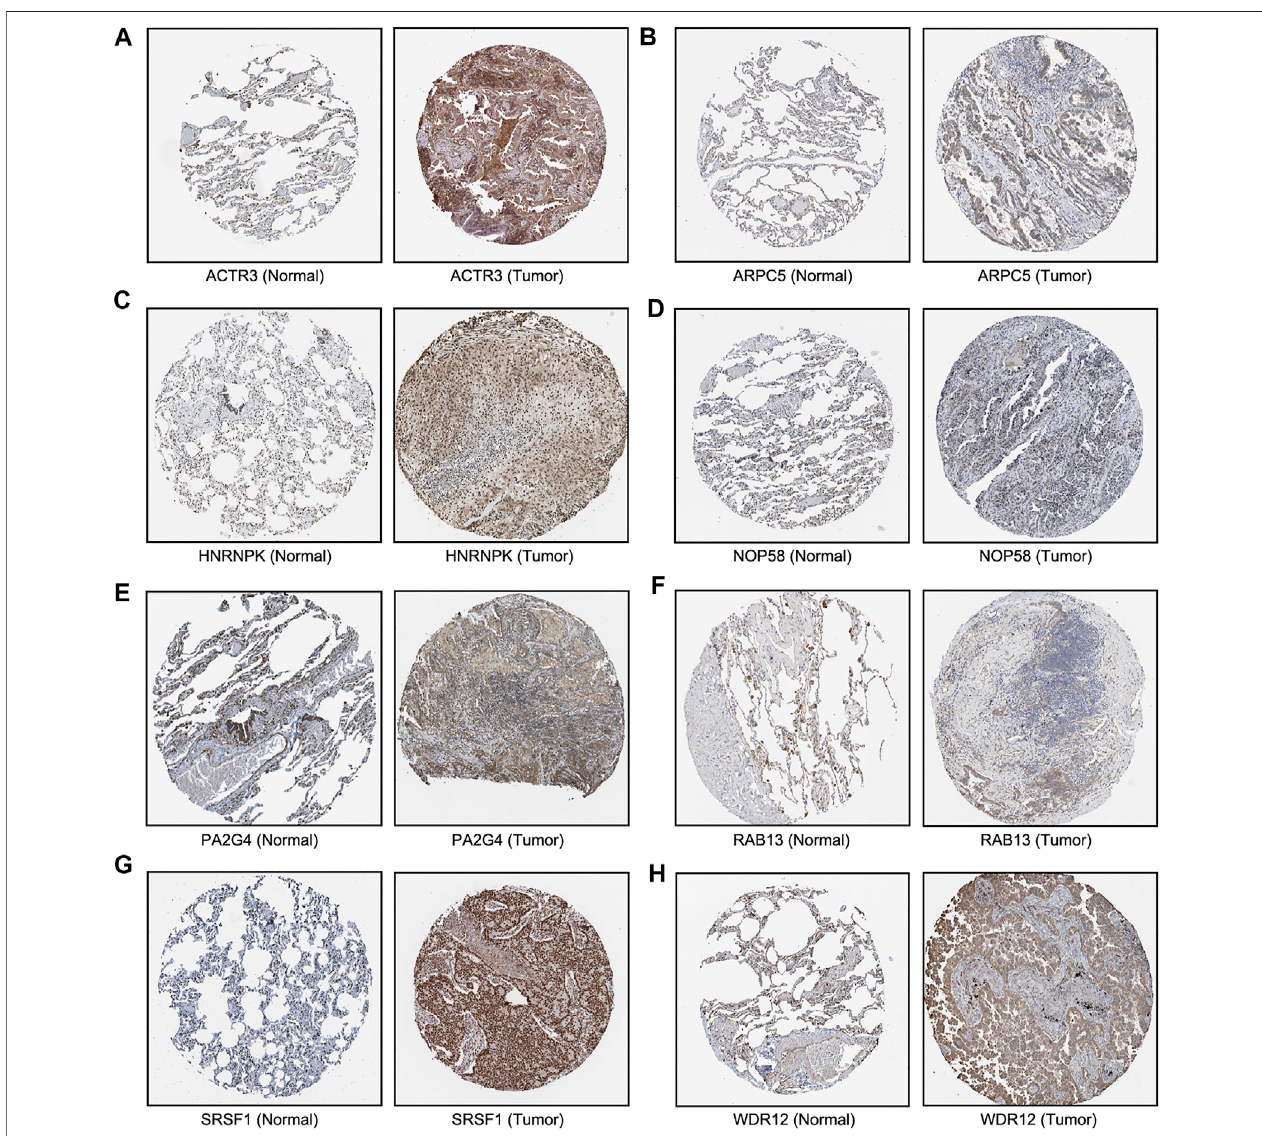
FIGURE 8 | Immunohistochemical images of eight hub genes in lung adenocarcinoma (LUAD) recurrence. The protein levels of (A – E) in LUAD tissues were compared with normal lung tissues from the Human Protein Atlas database.